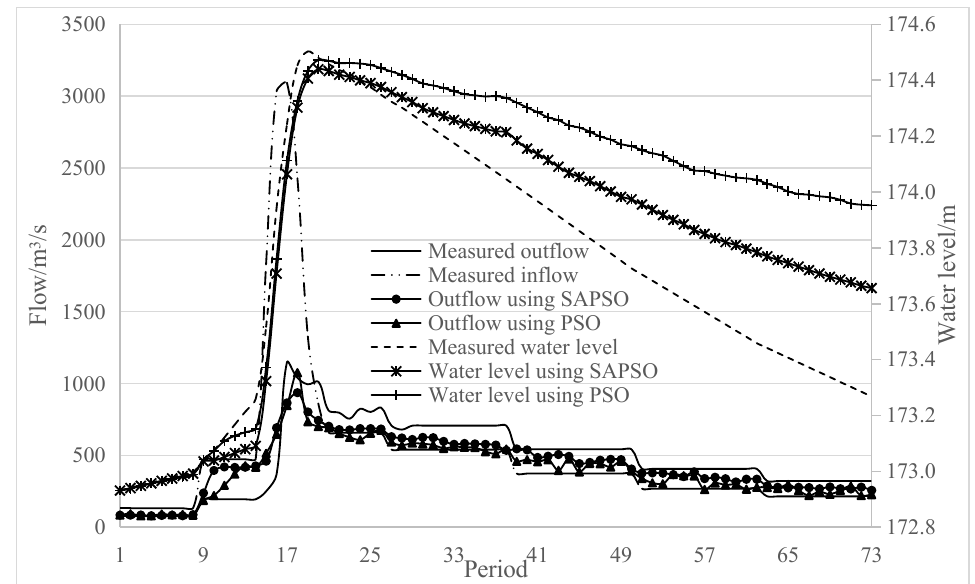
Figure 3. Operation hydrographs of Tianzhuang Reservoir for the 31 July 1964 flood.